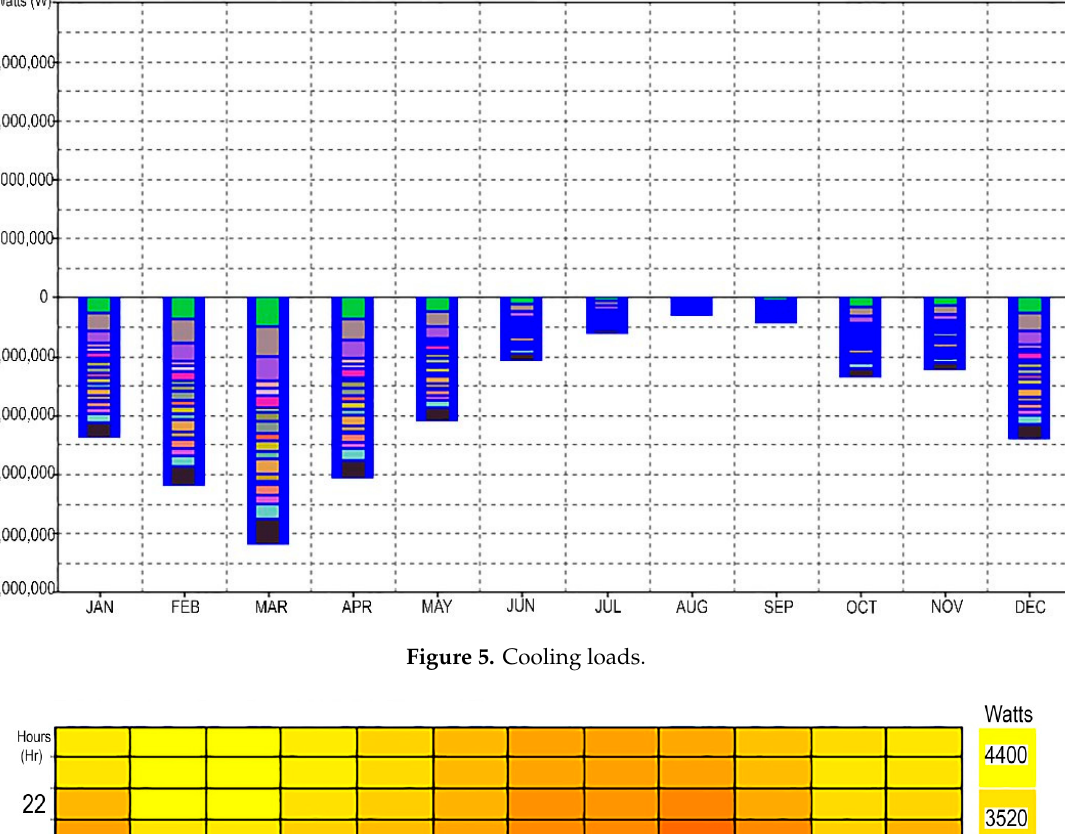
Figure 5. Cooling loads.